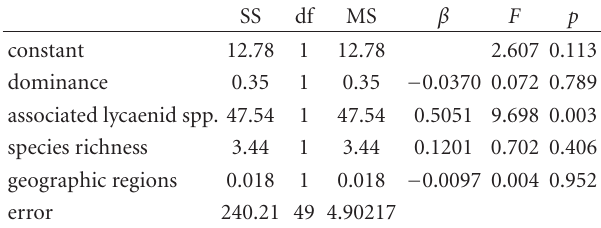
Table 2: Results of general linear model relating the number of parasitic lycaenid species associated with an ant genus to its species richness (log-transformed), ecological prevalence, geographical dis- tribution, and importance in nonparasitic lycaenid-ant associations (log-transformed). Given are standardized regression coe ffi cients β , and the F and p scores for each variable. SS: sum of squares; MS: mean of squares. Overall model fit: R = 0.5394, R 2 F = 5 . 0288; P = 0 . 4;49